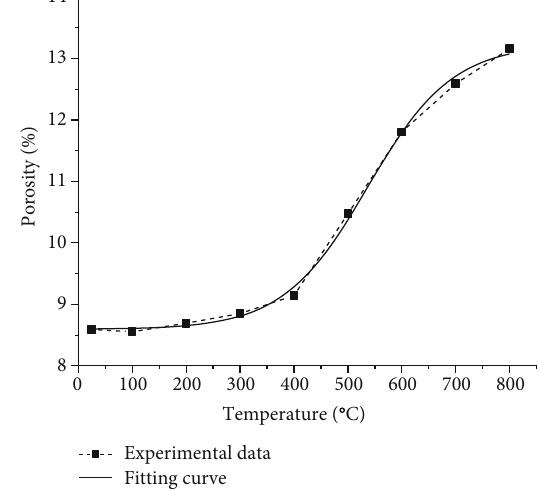
Figure 4: Porosity variation of the heat-treated